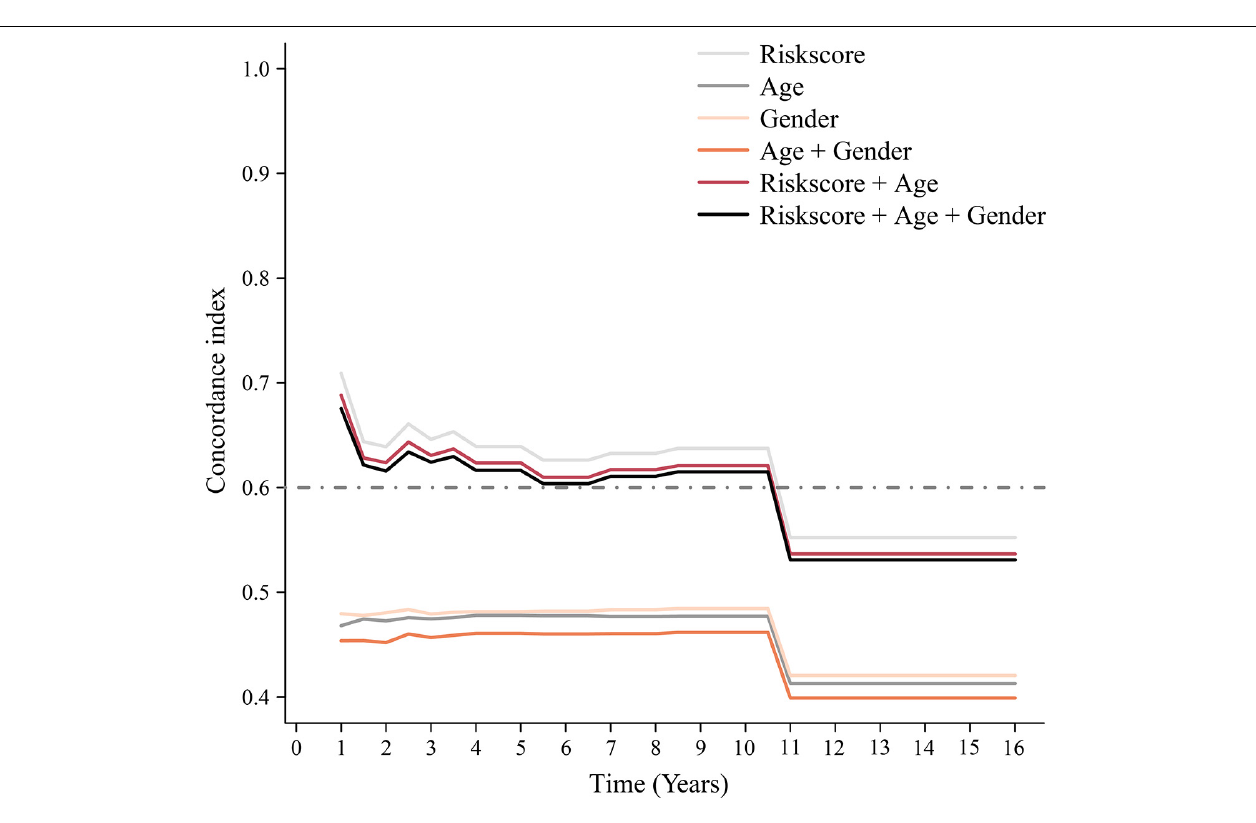
Frontiers in Cell and Developmental Biology |